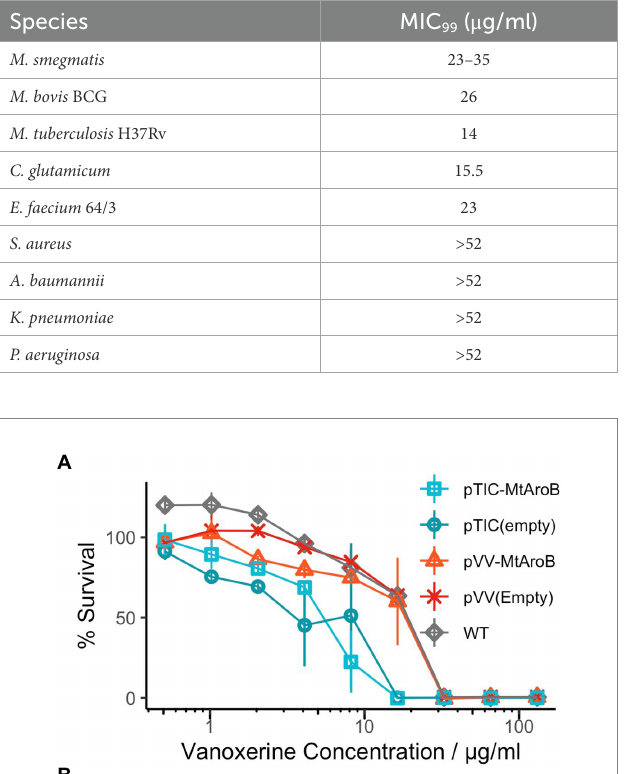
TABLE 1 Minimum inhibitory concentrations (MICs) of vanoxerine against representative species.